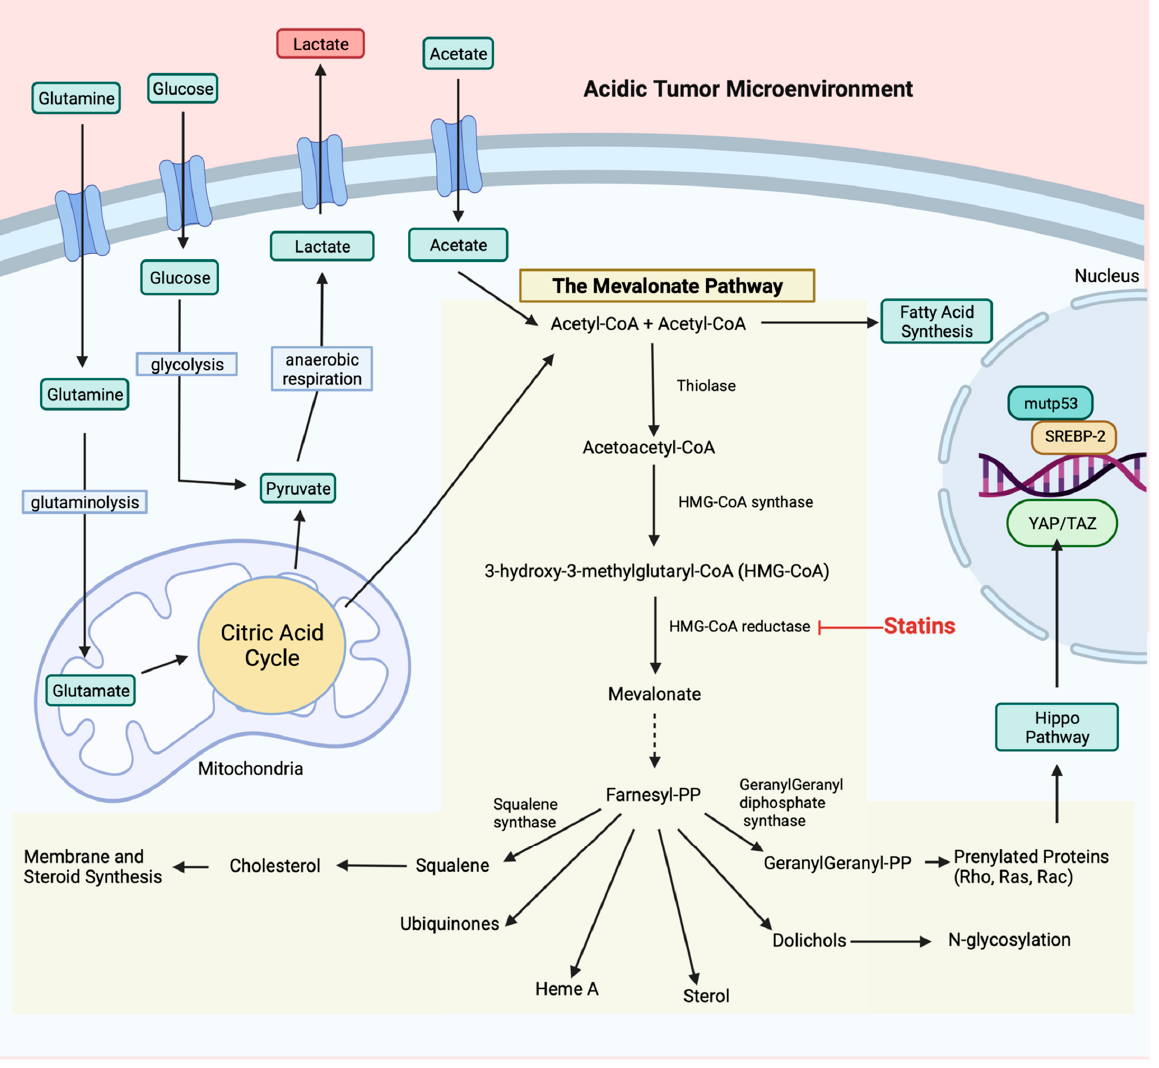
Figure 2. The regulation of the mevalonate (MVA) pathway and its role in promoting tumorigenesis. Tumor cells generate ATP through aerobic glycolysis and glutaminolysis, with lactate as a by- product. The extracellular accumulation of lactate contributes to an acidic and hypoxic tumor microenvironment. Mutant p53 interacts with SREBP-2 in the nucleus and dramatically increases MVA pathway enzyme transcription. The MVA route generates cholesterol, dolichols, ubiquinone and isoprenoids. Isoprenoids, particularly RhoA, inhibit the Hippo pathway, which prevents phosphorylation of YAP/TAZ. This enables YAP/TAZ to translocate to the nucleus and transcribe oncogenic target genes. Statin drugs competitively inhibit HMG-CoA reductase, the rate-limiting enzyme, of the MVA pathway. While aerobic glycolysis is primarily favored, tumor cells expand their energy production by involving protein biosynthesis and fatty acid synthesis as well. The mTOR pathway is known for regulating cell growth through facilitating biosynthesis of proteins, lipids and nucleic acids [21]. More specifically, fatty acid synthesis is critical to maintain membrane biosynthesis for rapid proliferation. Fatty acid synthesis in cancer is regulated by many factors, including: tumor suppressor p53 (TP53; p53), c-Myc, PI3K/Akt/mTOR